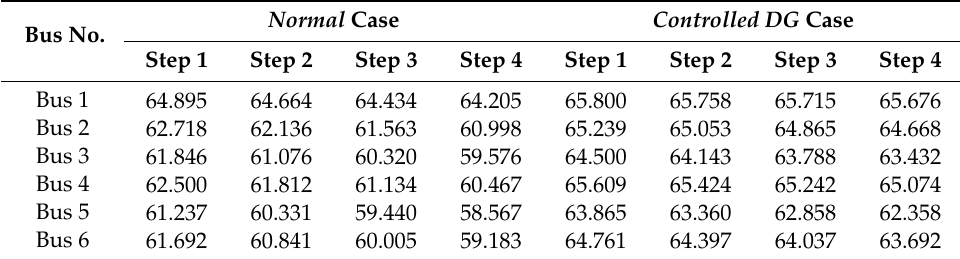
Table A4. Voltage values of busbars for all steps and both cases (kV). Bus No.